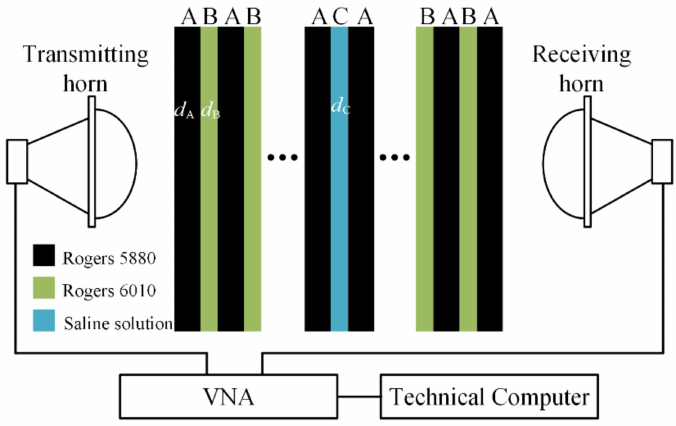
Figure 1. Schematic showing of the defective microwave photonic